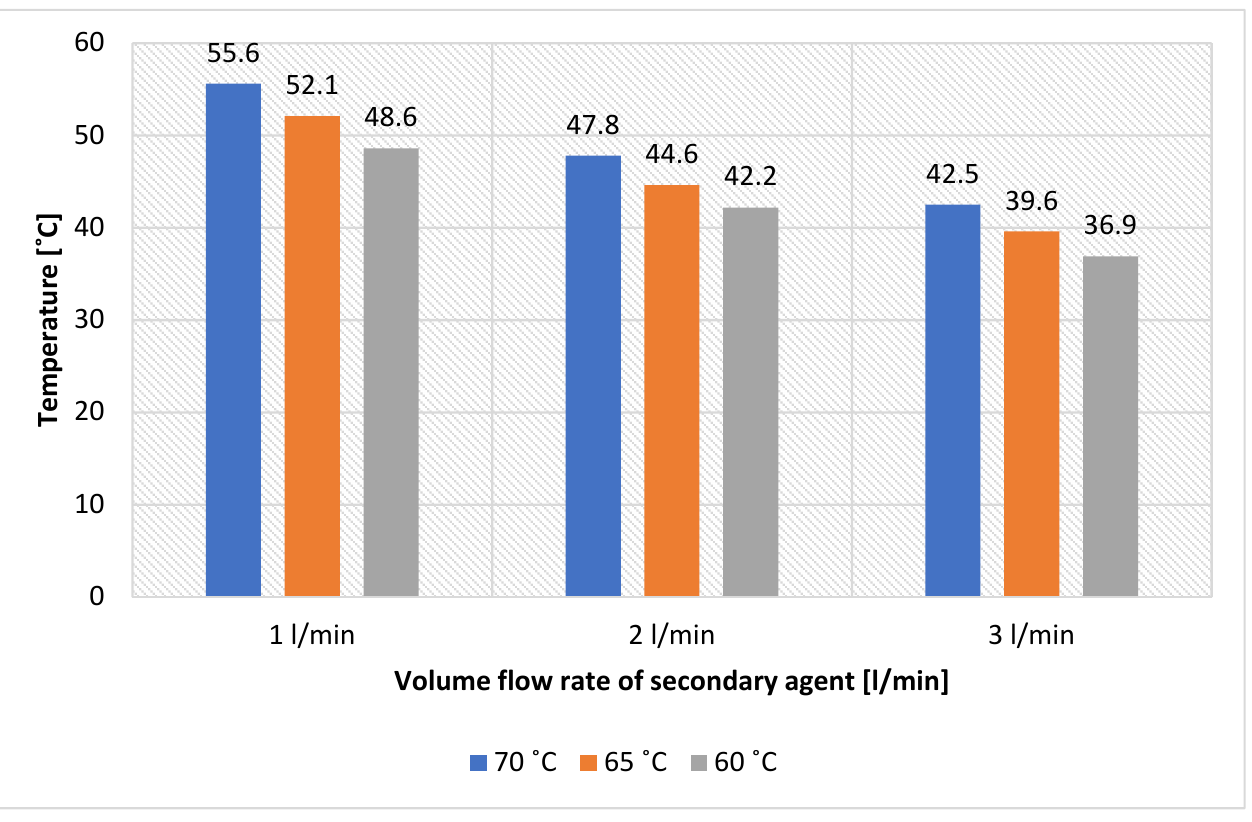
Figure 8. Results of the numerical simulations.